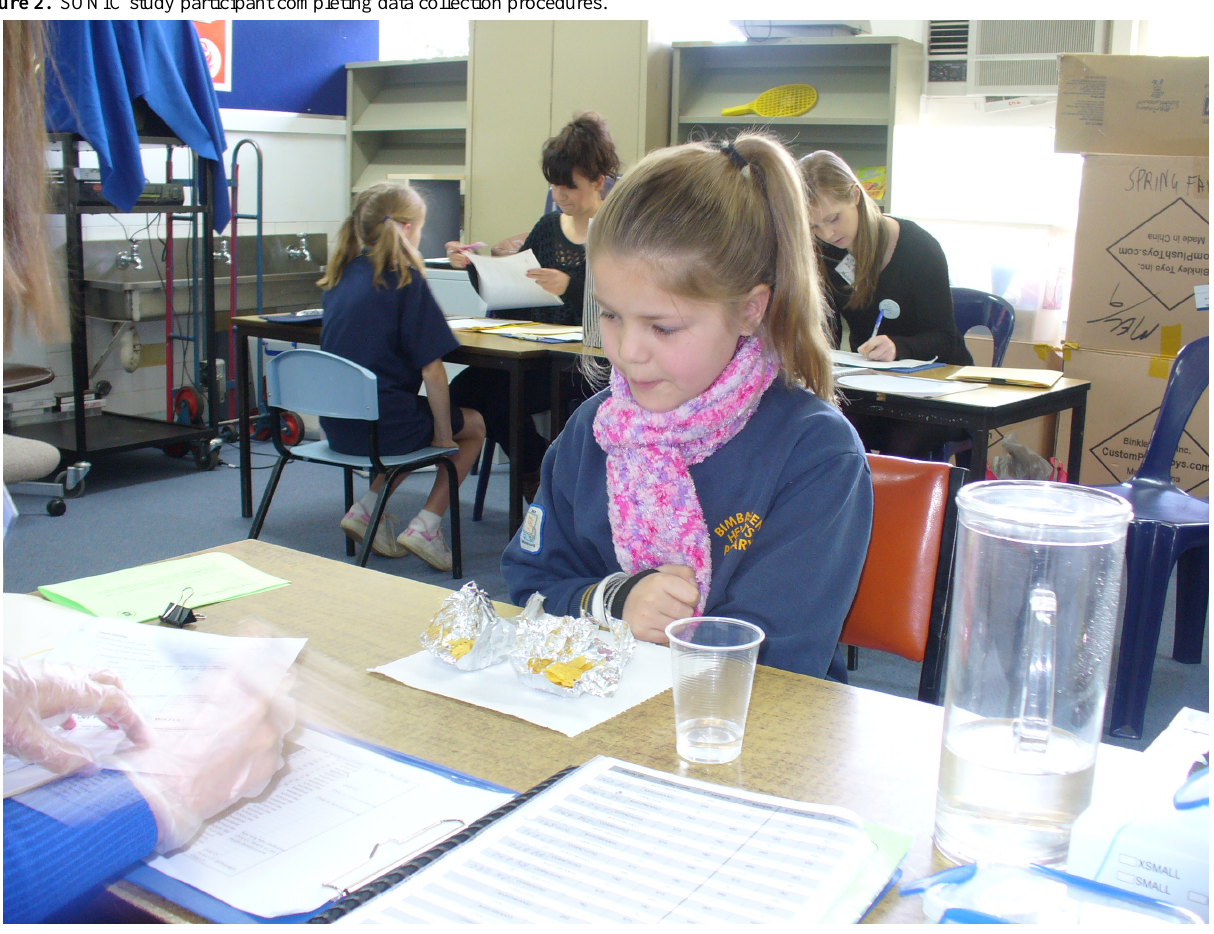
Figure 2. SONIC study participant completing data collection